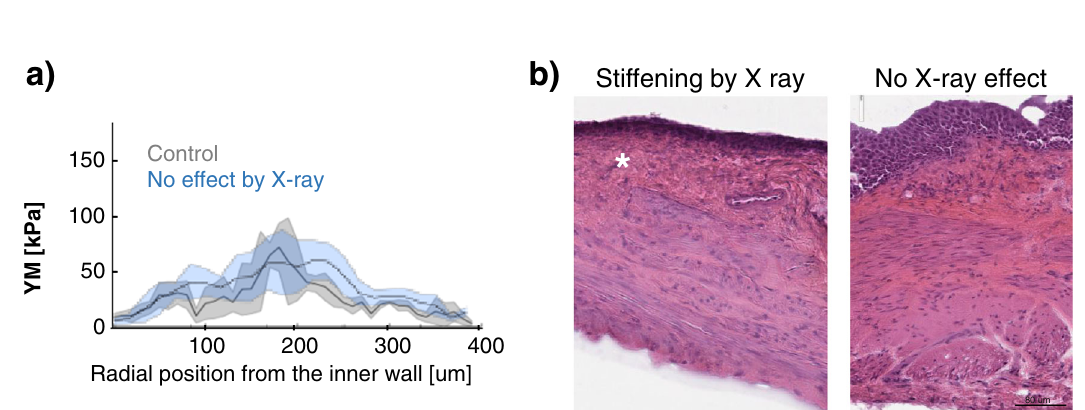
Fig. 2 Micromechanics of murine bladder in a model of actinic cystitis (X ray radiation). a Schematic representation of the experiment: X-ray radiotherapy is used to induce actinic cystitis on the bladder. Rats are sacri fi ced at different time points ant tissue elasticity is assessed. b Representative bladder wall stiffness gradient collected with the nanoindenter at month 4: X-ray causes a stiffening of the whole bladder wall compared to non-treated healthy animals. Mechanical spatial differences within the fi brotic bladder are maintained and associated to the different tissue layers (U: urothelium, L: lamina propria, M: muscle). c Kinetics of YM from X-ray radiated bladders at different time points (red) and comparison to healthy animals of the same age (grey) measured both with nanoindenter and AFM. N = 3 rats per time point and condition, each tissue layer of each single rat was characterized by over 3000 force curve measurements. Data shown are logarithm in base 10 of YM ’ s (in Pa). d Fold of change of mean of the median log10 YM values of tissue layers of treated rats respect to age-matched control rats. T-test showed statistically signi fi cant stiffening with respect to the control animals (mean ± standard deviation with propagated error are shown. ns = not signi fi cant, * = p value < 0.05, ** = p value < 0.005). e Mean of the median log10 YM values of tissue layers of each rat ± SEM. 2-way Anova showed no statistical signi fi cant differences in kinetics of fi brosis development. f ) Quanti fi cation of the bladder area that expressed collagen from control rats and X ray-irradiated animals at different time points; each symbol represents the measurement in a tissue slice, with multiple slices measured for each bladder, in three animals. Source data behind graphs and charts can be found in https:// fi gshare.